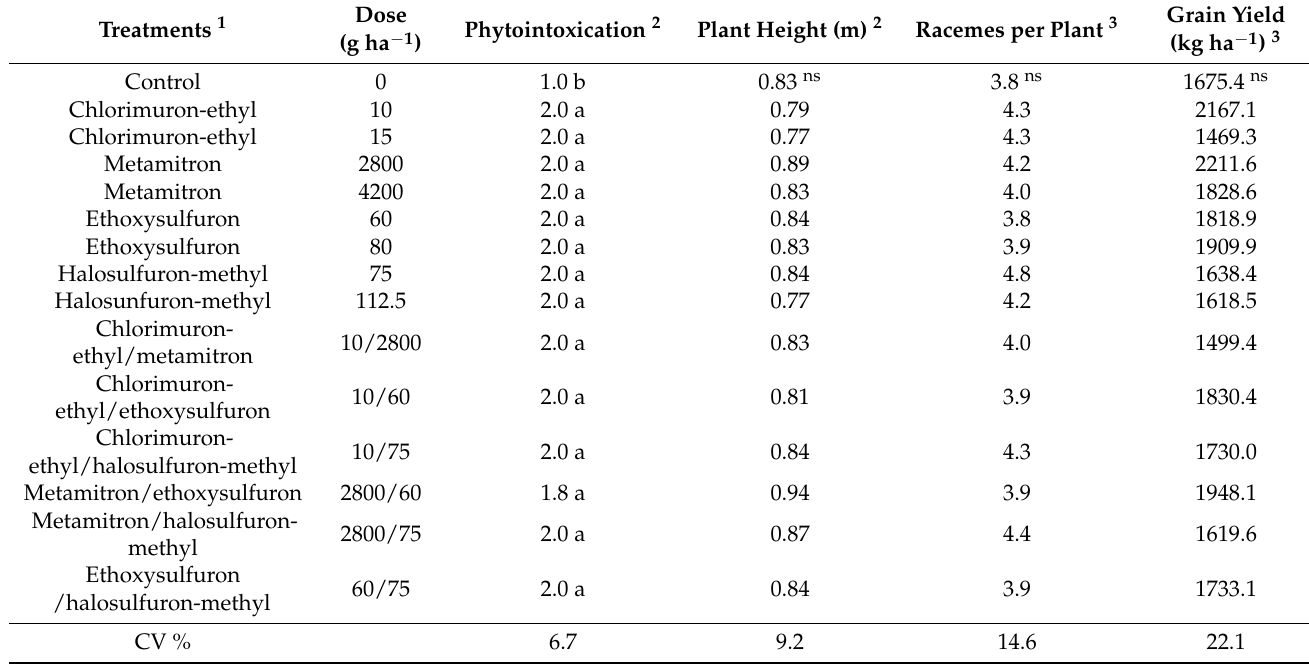
Table 2. Phytointoxication, plant height, racemes per plant, and seed yield of castor ( Ricinus communis L.) under weed management combining pre and postemergence